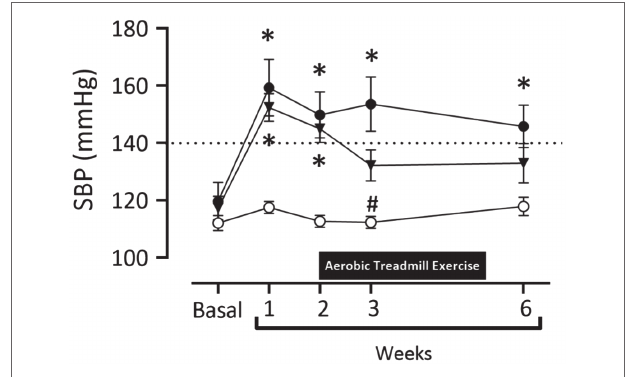
FIGURE 2 | Systolic blood pressure values (mmHg) in normotensive and hypertensive rats by the 2K1C experimental model. Experimental groups: ○ Sham; ● 2K1C; and ▼ 2K1C + Exercise. Data are presented as mean ± SEM was used, two-way ANOVA, followed by Tukey’s test.